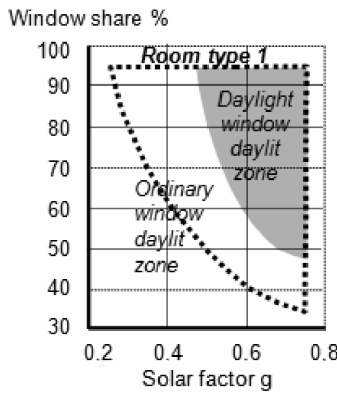
Fig. 8. Possible combinations of window glass share and solar factor that fulfil the requirement for a daylight factor of 2 or above, comparing ordinary and daylight windows